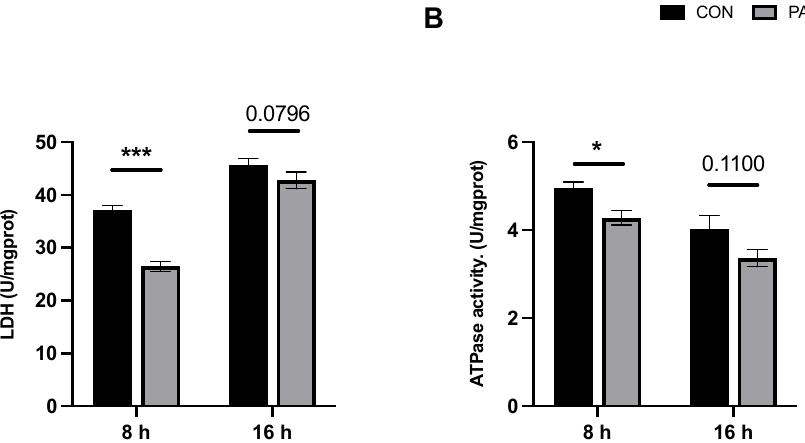
Figure 3. The lactate dehydrogenase (LDH) activity ( A ) and Na + –K + ATPase activity ( B ) of L. plantarum CCFM1287 exposed to different reaction times. (* p < 0.05, *** p < 0.001 vs. control group)